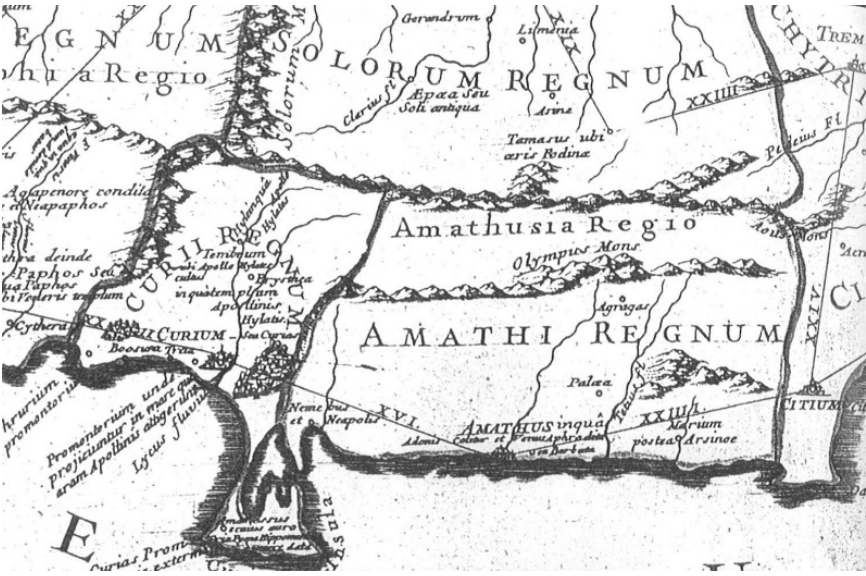
Figure 17. A map dating to 1718 but copying earlier maps showing the Roman military road network,